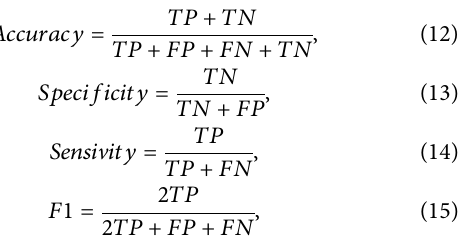
Frontiers in Physiology |